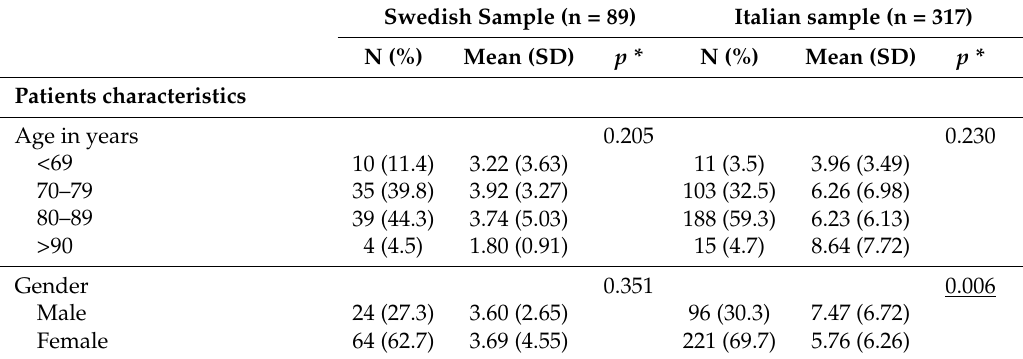
Table 3. Time spent in informal caregiving and psychological health of informal